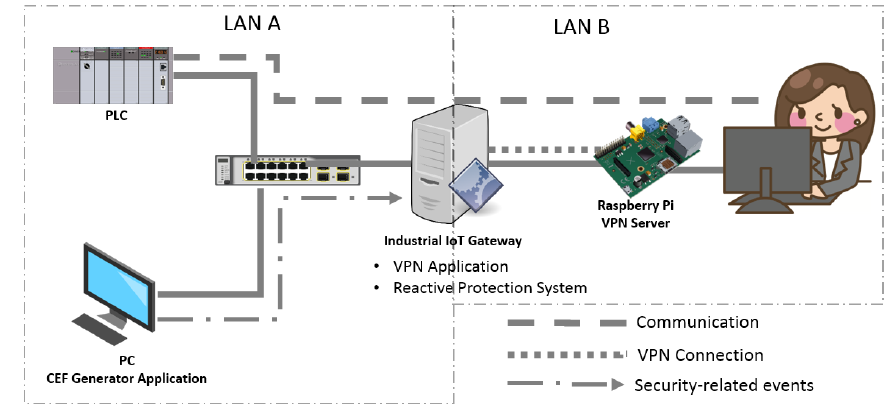
Figure 6. Emulation of an industrial scenario of a remote maintenance application Figure 5. LAN: Local Area